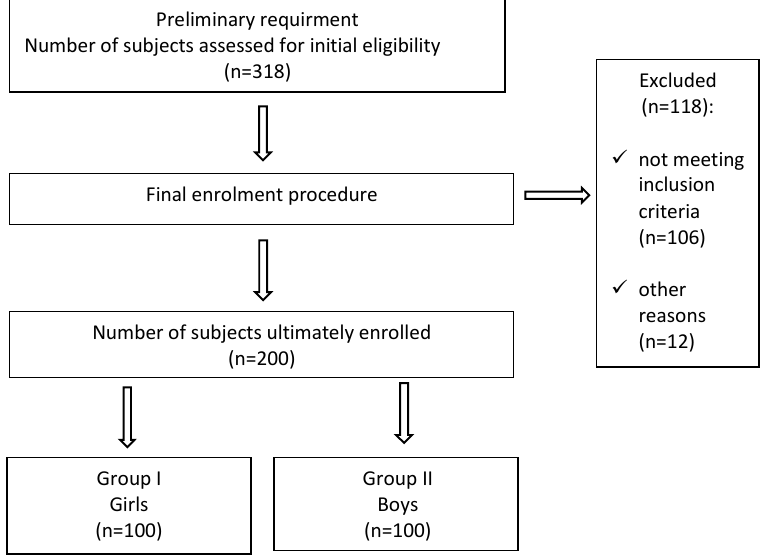
Figure 1. Flow of participants through the study.